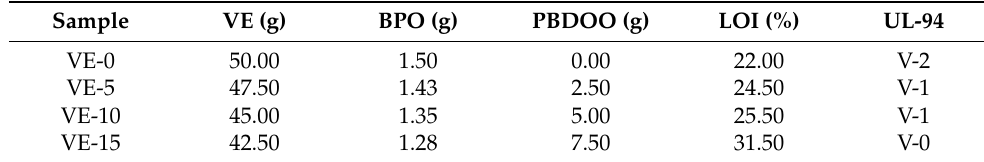
Table 3. LOI and UL-94 results of the VE